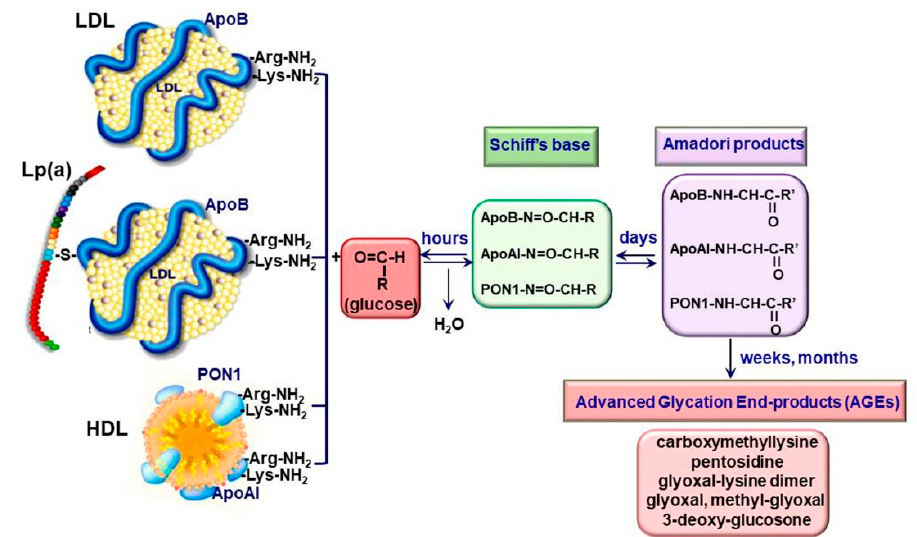
Figure 1. Formation of irreversibly glycated lipoproteins by Maillard reactions.